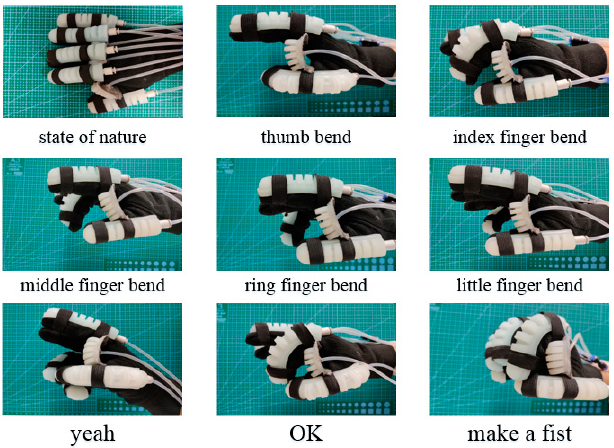
Figure 22. Experimental of gesture training for SRGs.